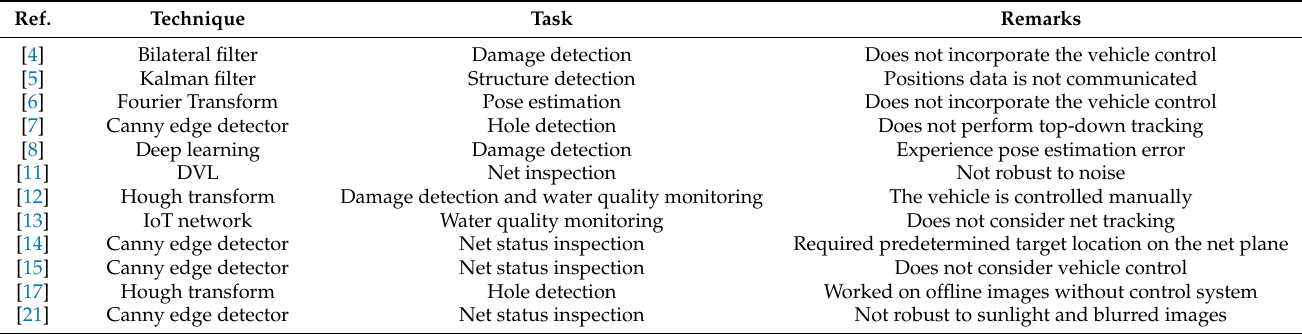
Table 1. Review of fish net tracking and inspection